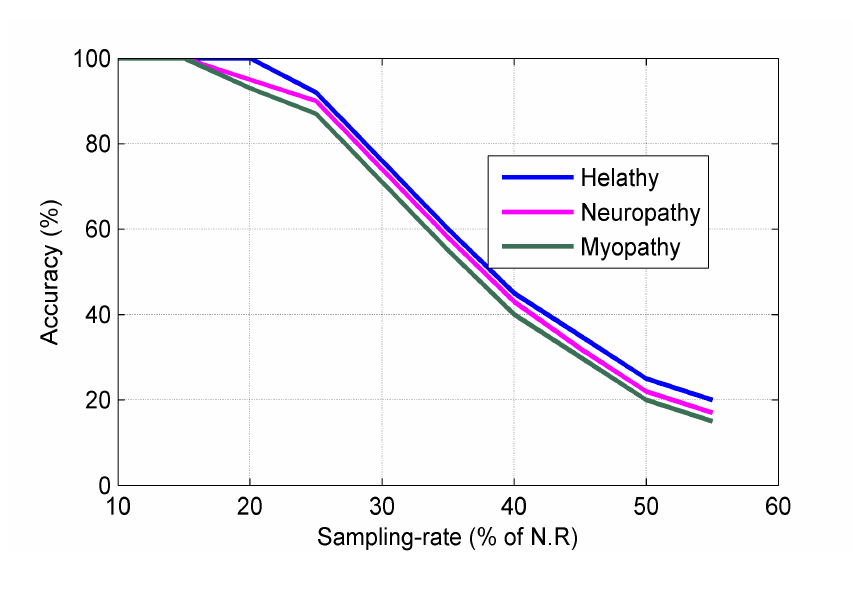
Figure 10. Sampling rate.